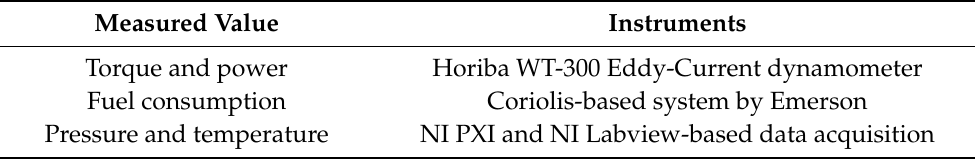
Table 3. Experimental setup and